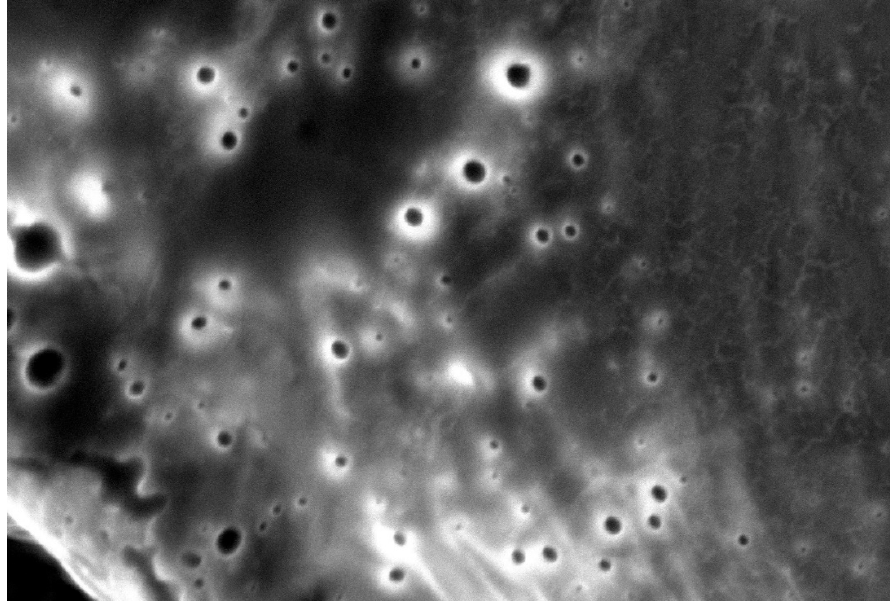
Figure 11. SEM of the optimized formulation of MA/EA copolymer NPs loaded with glibenclamide, size 19nm magnification 2500×.